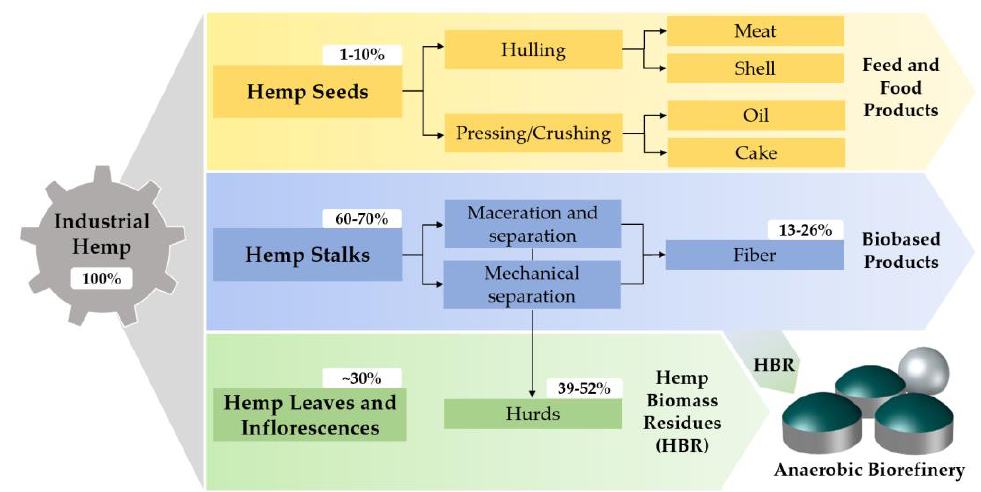
Figure 1. Breakdown of industrial hemp plant components, products and potential uses. Percentage values relate to the typical composition of the industrial hemp plant in terms of the dry weight of the whole plant biomass. Values for fibers (expressing the total of primary and secondary fibers) and hurds were calculated by considering an average of 65% of stalk dry weight [15]. Adapted from Ingrao et al. [7].